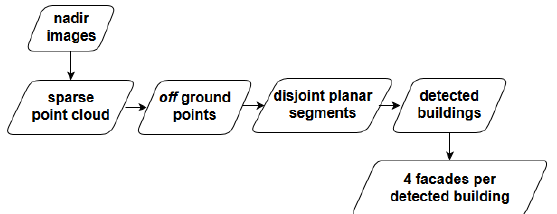
Figure 3 Building extraction and facade definition flowchart